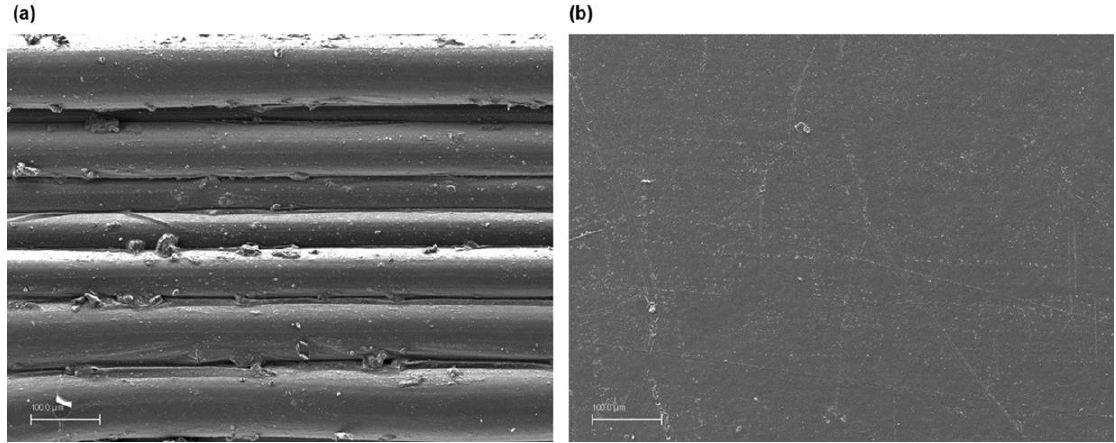
Figure 6. Polycarbonate component manufactured with 3D FDM printing without chemical treatment 1000 × ( a ) and with dichloromethane chemical treatment 1000 × ( b ). Materials 2020 , 13 , x FOR PEER REVIEW